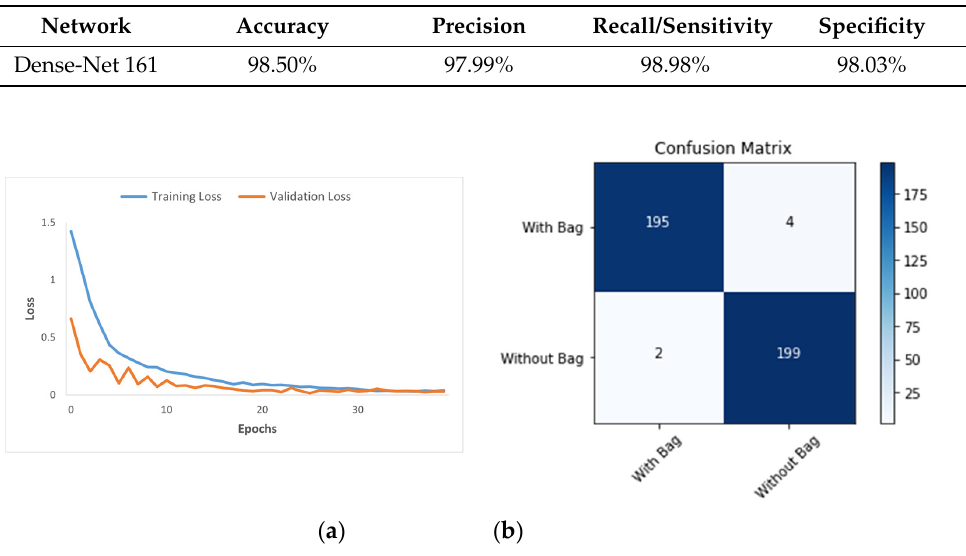
Figure 5. The loss curve and confusion matrix of binary classification on the PETA dataset: ( a ) The loss curve, ( b ) the confusion matrix.